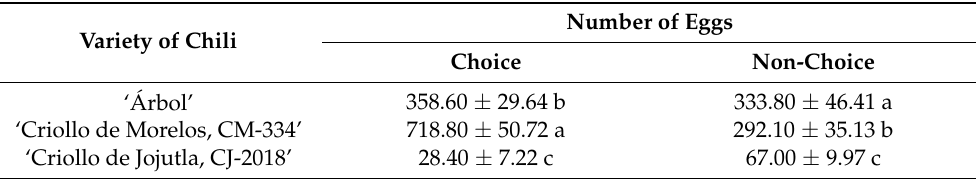
Table 1. Preference of oviposition of Bactericera cockerelli for 6 days on three varieties of pepper, under two conditions: choice and